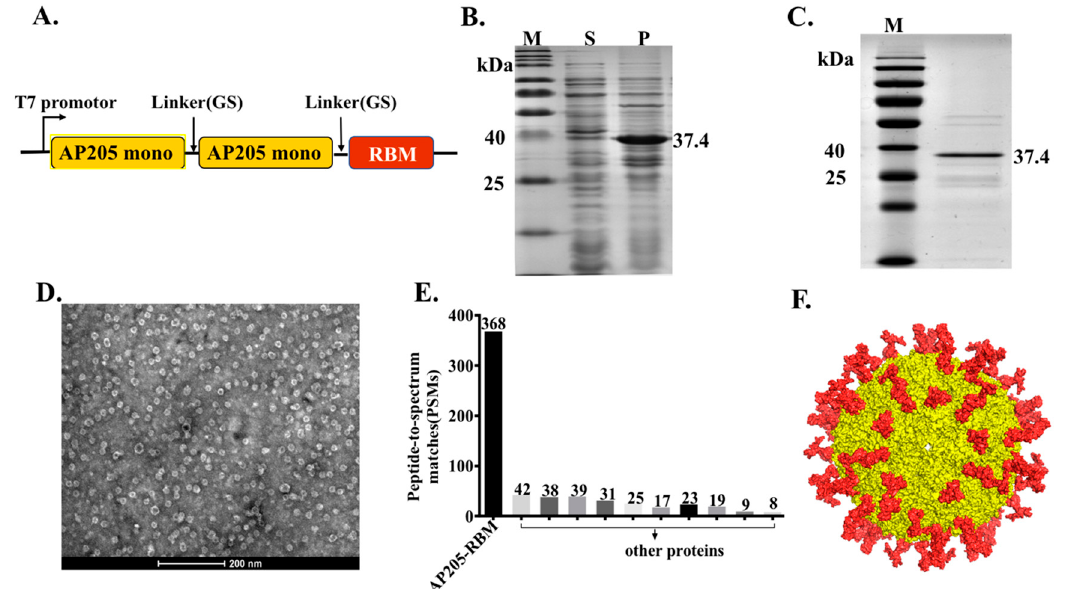
Figure 1. The bacteriophage AP205-VLPs can be used efficiently for generating a fusion vaccine against SARS-CoV-2. ( A ) Schematic representation of AP205-RBM coat protein fusion construct. ( B ) 12% SDS-PAGE for AP205-RBM expression in E . coli showing soluble (S) and insoluble (P) fractions. ( C ) 12% SDS-PAGE showing the purified AP205-RBM vaccine of ~37.4 kDa. ( D ) Electron Microscopy of negatively stained AP205-RBM VLPs showing a size of ~30 nm, scale bar 200 nm. ( E ) MALDI-MS of AP205-RBM vaccine. ( F ) 3D model of AP205-RBM vaccine illustrating AP205 CP in yellow and the genetically fused RBM in red.